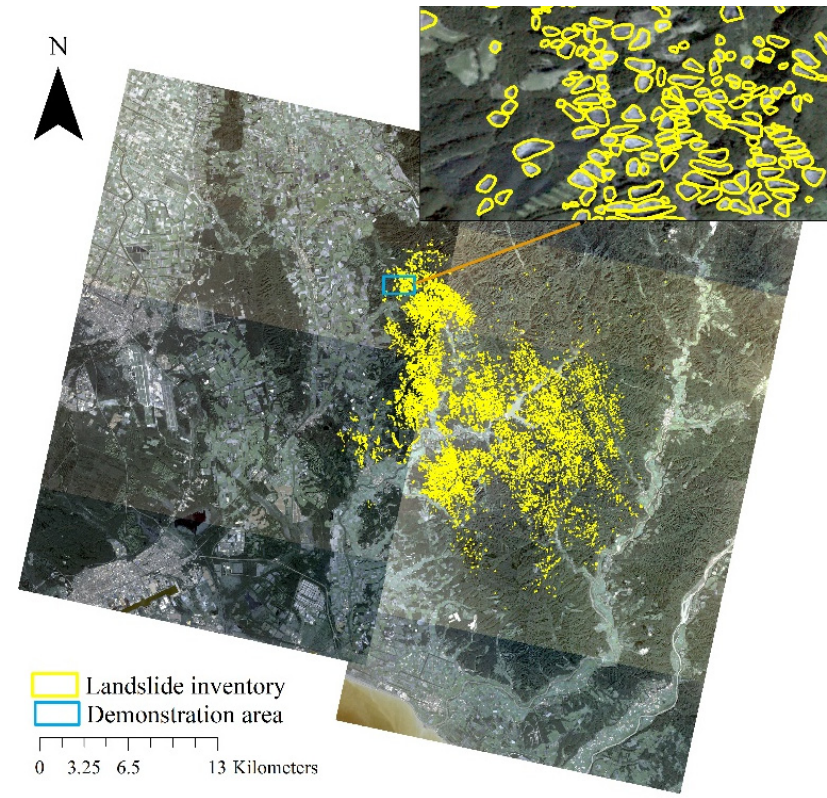
Figure 7. Landslide inventories of the Iburi earthquake-triggered landslide dataset.